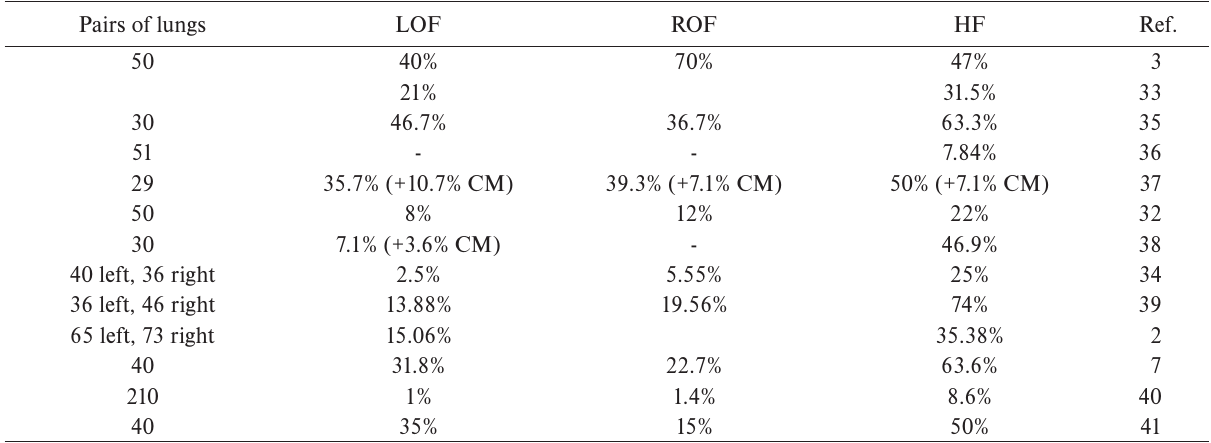
Table 2. Frequencies of incomplete fissures obtained from autopsies.